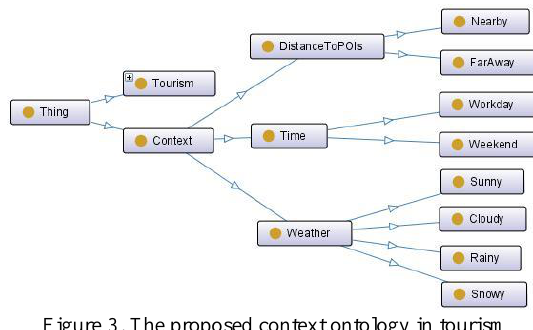
Figure 3. The proposed context ontology in tourism The context factors impact on the POIs recommendation are modeled by context relations. A context relation defines a link between a context factor in the context model, and a POI class in the domain model. It has a relevance weight that represents the importance of the domain item in a context factor. Therefore, the domain knowledge and context factors are treated as concepts in the ontology and are linked to each other and form a semantic